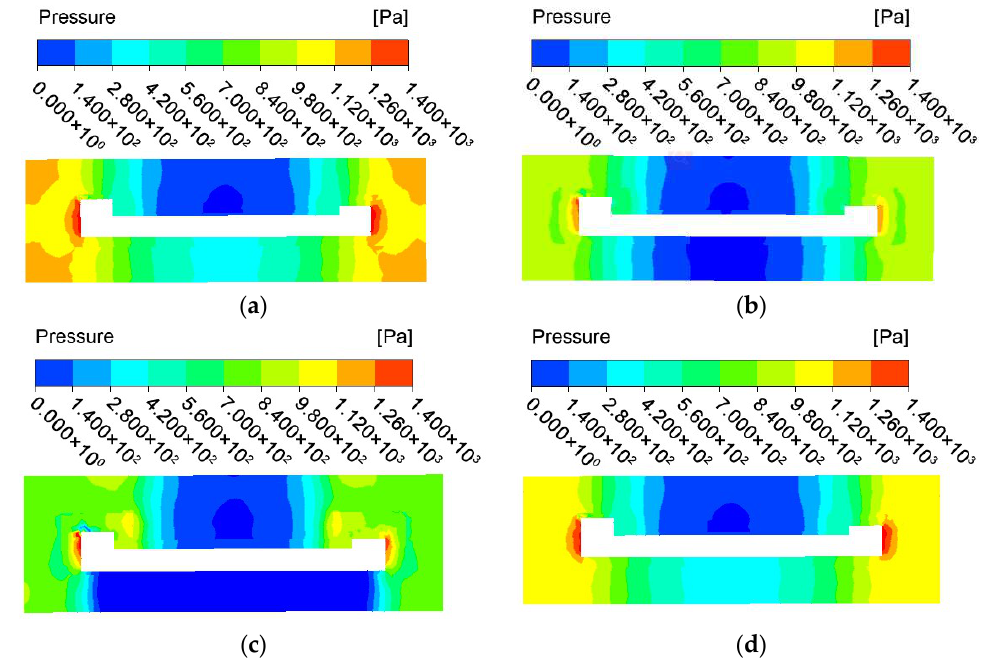
Figure 12. Static pressure contours on Section 1 under di ff erent values of c 1 : ( a ) 2.5 mm; ( b ) 5 mm; ( c ) 7.5 mm; ( d ) 10 mm.